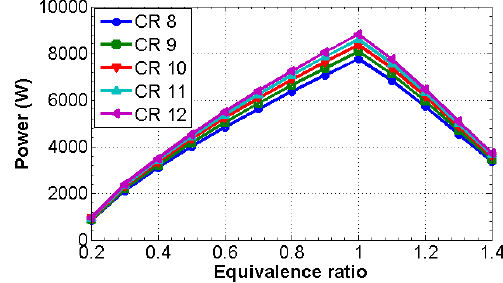
Figure 5. Variation of power developed with the fuel-air equivalence ratio at various compression ratios. Effect of power developed on compression ratio